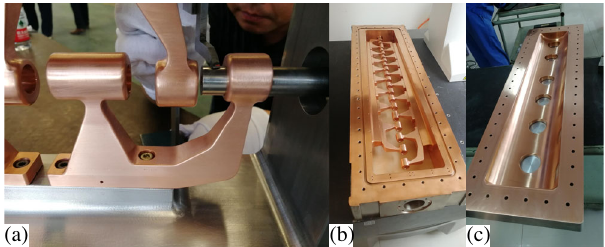
FIG. 1. (a) Mechanical design of the IH-DTL. (b) Main cross- sectional view of the IH-DTL and the drift tube. (c) Side cross- sectional view of the IH-DTL. (d) Top cross-sectional view of the IH-DTL.